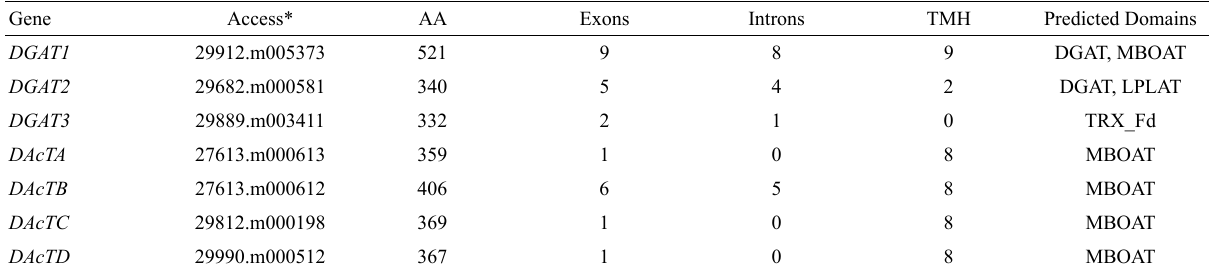
Table 1 – DGAT1 , DGAT2 and homologous genes of EaDAcT and AhDGAT3 identified in castor bean ( Ricinus communis L.).